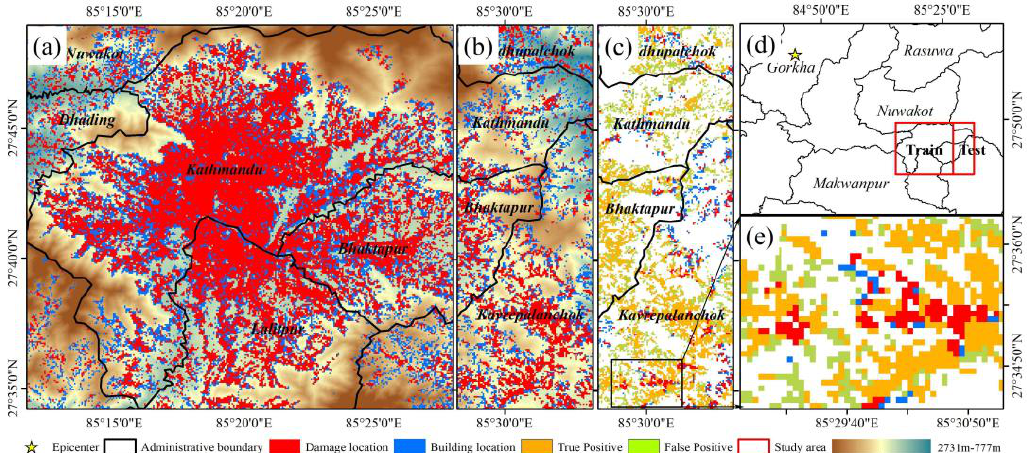
Figure 11. Map of building damage assessment in Kathmandu. Subplot ( a ), terrain, building, and damage information of the training area; subplot ( b ), terrain, building, and damage information of the test area; subplot ( c ), the damage assessment in test area; subplot ( d ), the epicenter, the training area, and test area; subplot ( e ), detailed display of the classified result in the black box. Orange pixels represent damaged pixels classified correctly, and green pixels represent damaged pixels classified incorrectly.